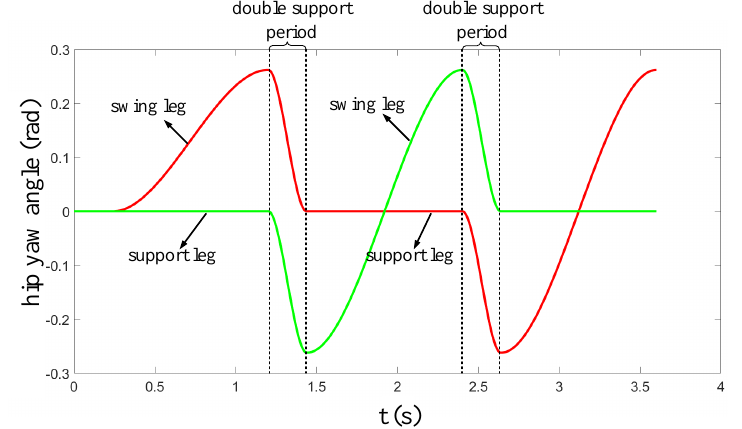
Figure 15. Hip yaw angle characteristics.